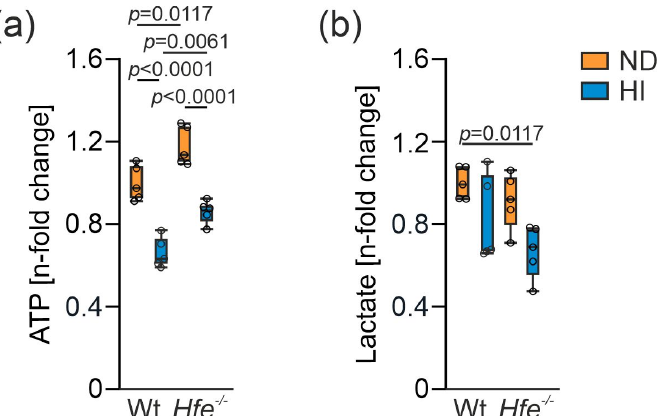
Figure 6. Changes in liver adenosine triphosphate (ATP) and lactate concentration due to dietary and genetic iron overload. ( a ) ATP and ( b ) lactate concentration. Values are depicted as n-fold change of Wt ND. All results were obtained from snap-frozen samples. n = 5 mice per group. Two-way ANOVA: ( a ) diet, F (1,16) = 88.29, p < 0.0001; genotype, F (1,16) = 28.17, p < 0.0001; diet X genotype, F (1,16) = 0.05114, p = 0.8240; ( b ) diet, F (1,16) = 10.71, p = 0.0048; genotype, F (1,16) = 3.268, p = 0.0895; diet X genotype, F (1,16) = 0.2411, p = 0.6301. Values are shown as median ± interquartile range. The exact p -values are indicated in the graphs.